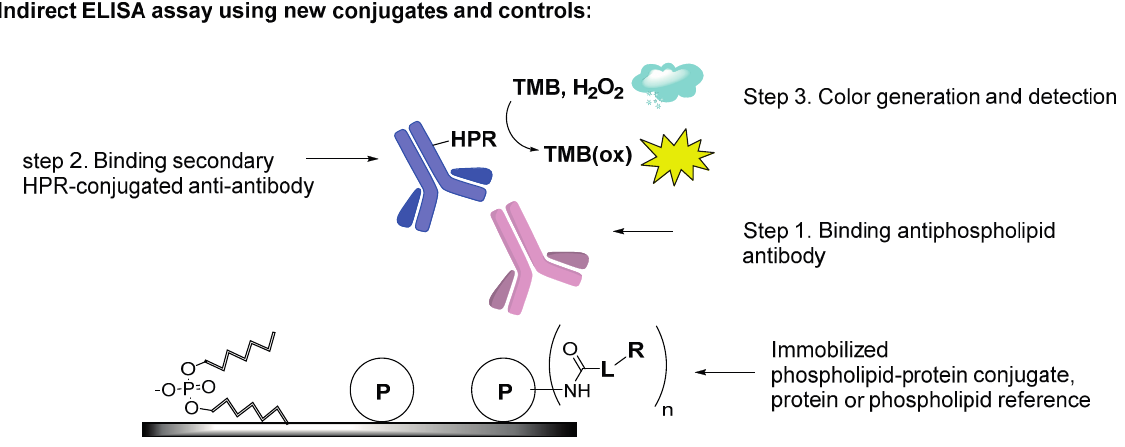
Figure 2. Representative scheme of enzyme-linked immunosorbent assay (ELISA) for detection of Abs against antigens used in this study: phospholipids, proteins and phospholipid-protein conjugates. P = protein, L = linker, R = phospholipid residue, TMB = 3,3 ʹ ,5,5 ʹ -tetramethyl benzidine , HPR = horseradish peroxidase. Table 1. Results of IgG ELISA assay using controls and conjugates prepared in this study *. Absorbance at 450 nm: Analyte Antigen a-PL a- β